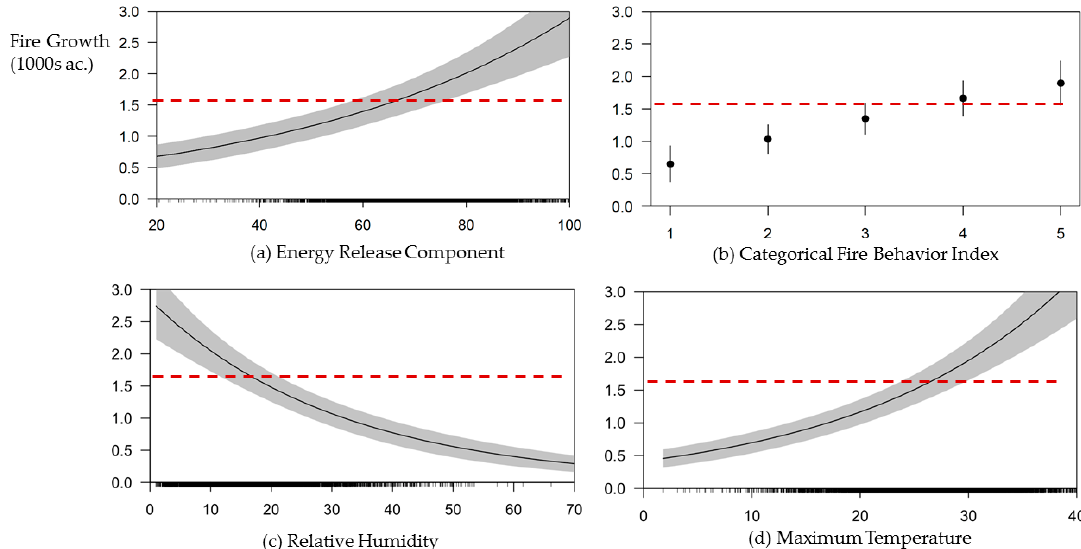
Figure 3. Predicted fire growth response to relevant weather conditions: ( a ) Energy Release Component, ( b ) Categorical Fire Behavior Index, ( c ) Relative Humidity, and ( d ) Maximum Temperature. The black lines represent the predicted fire growth, and the shaded area represents 95% confidence intervals from the quasi-Poisson regression of fire growth on weather conditions. The red dashed lines are the mean growth in the data (1.65 from Table 3). The small hash marks along the horizontal axis indicate the density of observations.